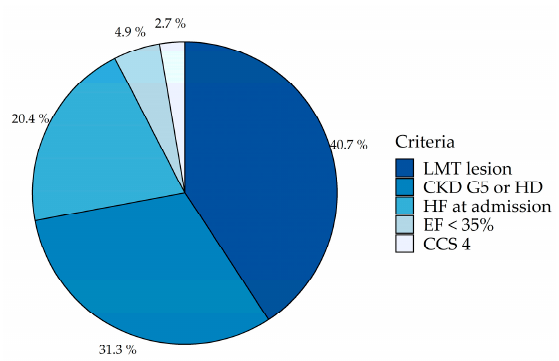
Figure 2. The frequency of observed exclusion criteria of the International Study of Comparative Health E ff ectiveness with Medical and Invasive Approaches (ISCHEMIA) trial in JCD–KiCS. Abbreviations: LMT, left main coronary trunk artery; CKD G5, chronic kidney disease grade 5; HD, hemodialysis; HF, heart failure; EF, ejection fraction; CCS, Canadian Cardiovascular Society functional